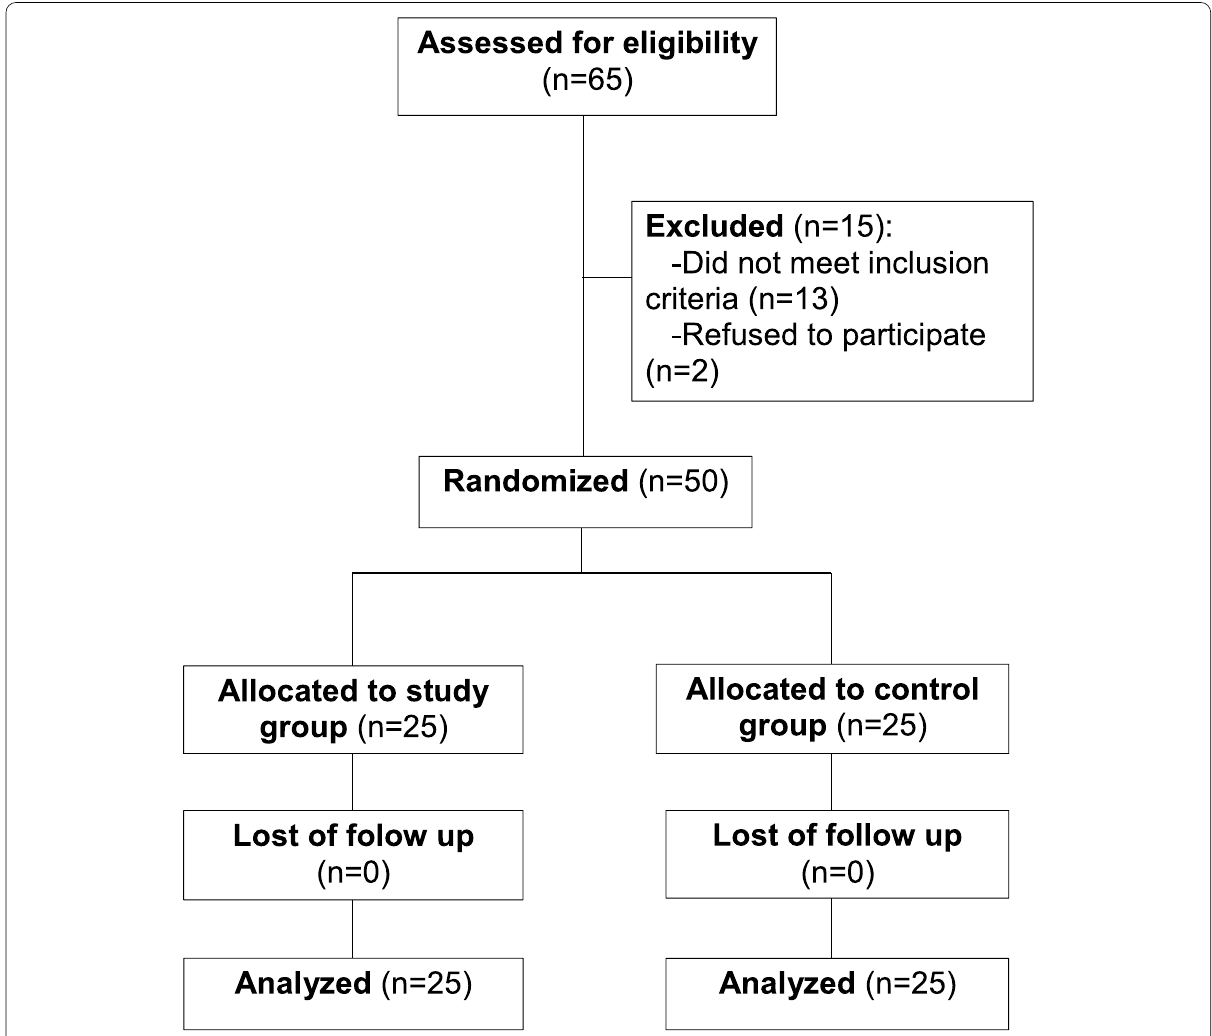
Fig. 1 CONSORT. Participant flow